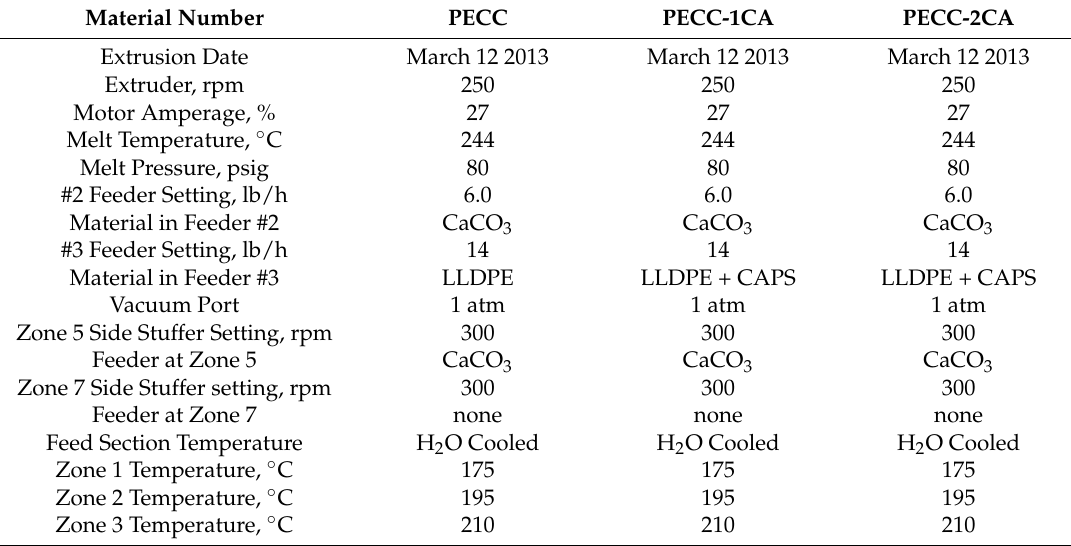
Table 1. Extrusion conditions.